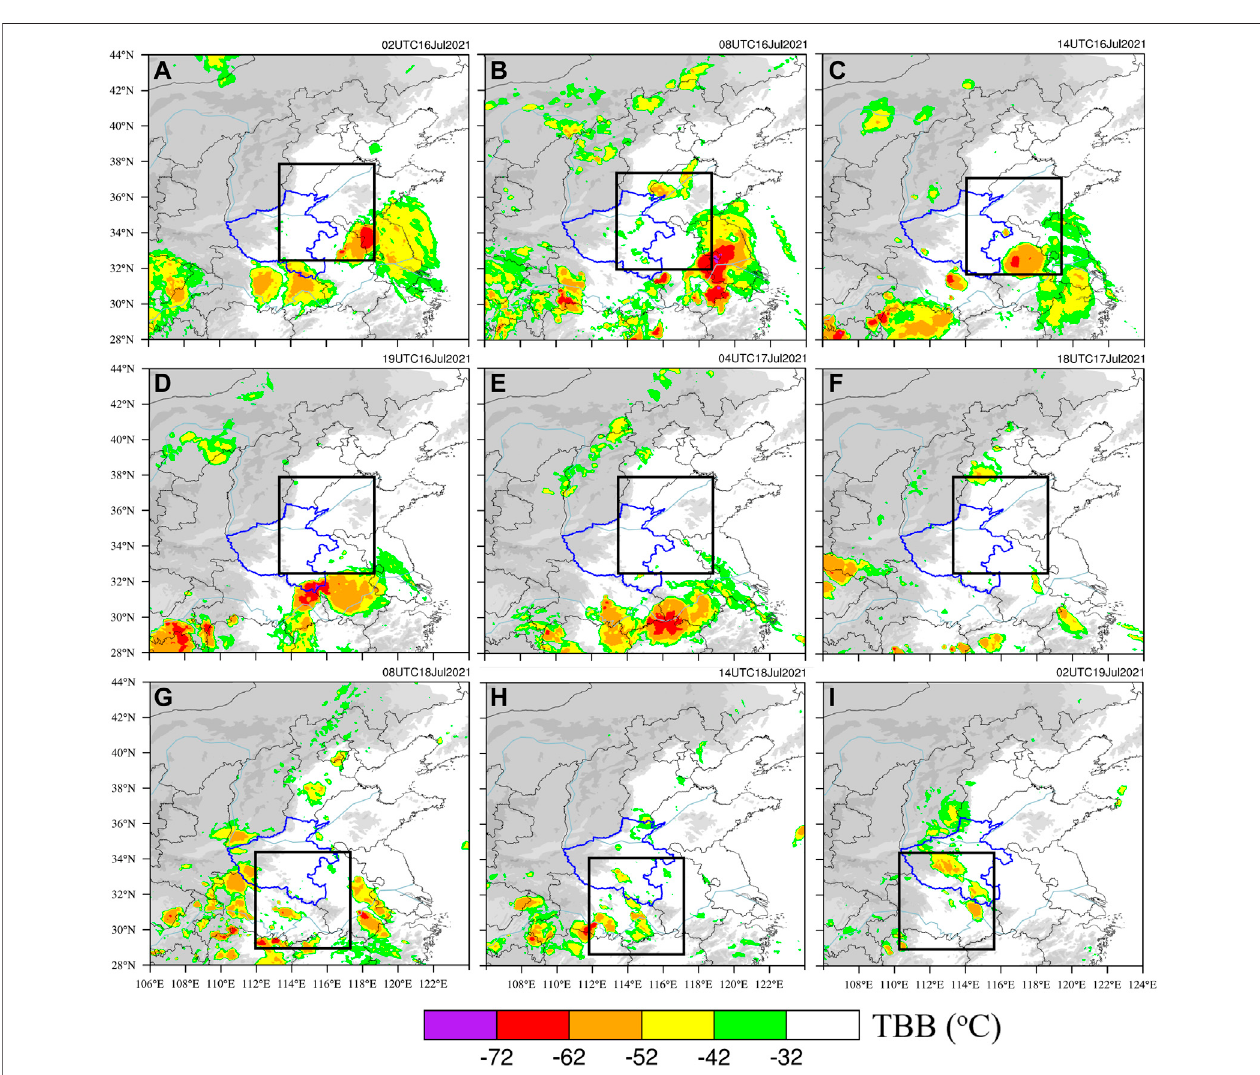
FIGURE5| TBB(shading, units: ° C) duringtypical stages ofthevortex, wherethe grayshadingrepresents terrain and theblack boxesoutlinethemainbodyofthe vortex.